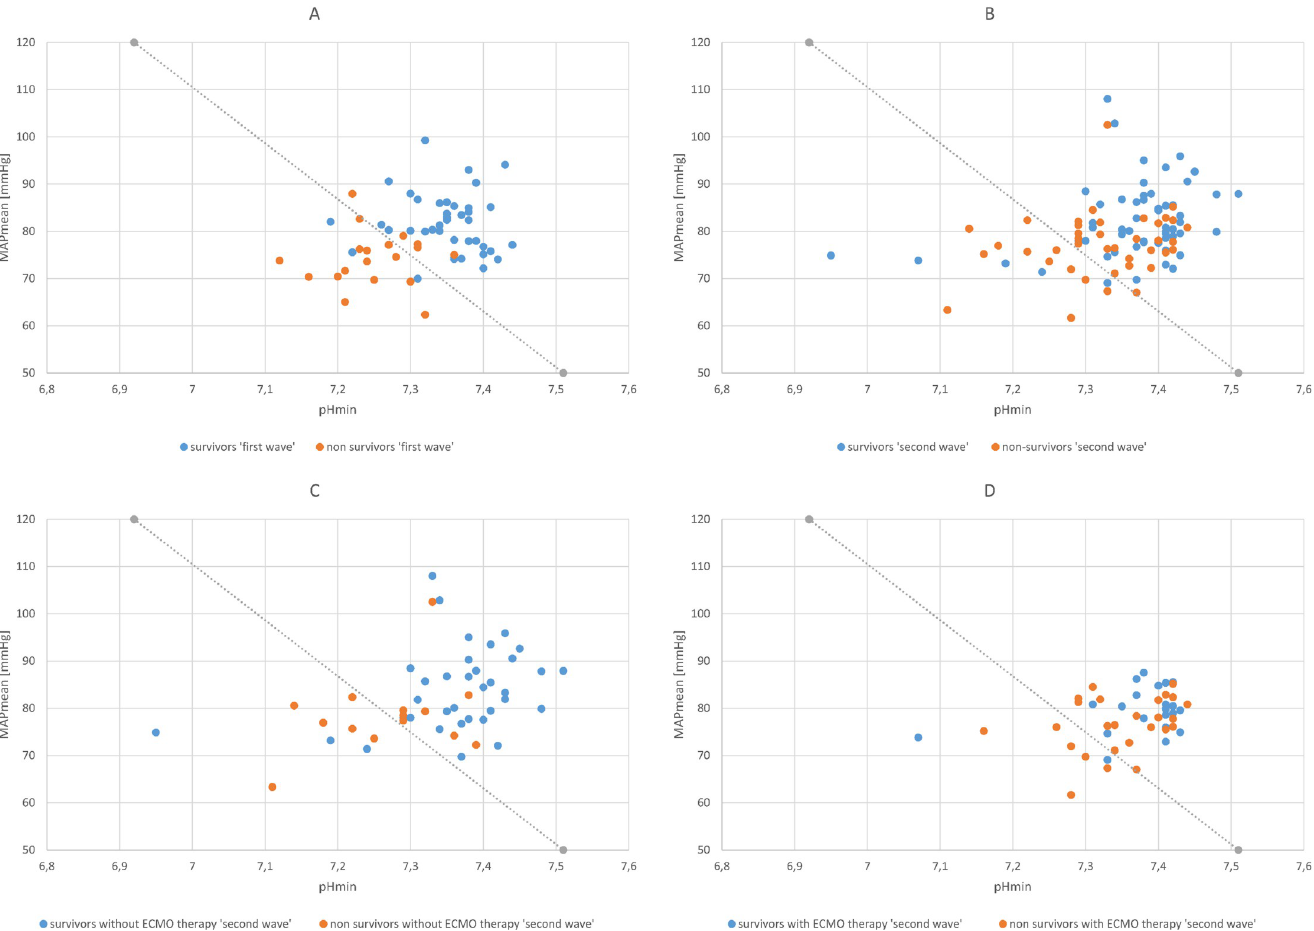
Fig 2. Visualization of the prognostic power of the multivariable regression model and comparison of the first-wave cohort with the second-wave cohort. The cut-off line drawn in the diagrams separates the plane spanned by pHmin and MAPmean into a region below this line with a survival probability < 0.50 and into a region above this line with a survival probability > 0.50. The values calculated for each patient are plotted in the diagram. 2A: All patients of the first-wave cohort. The cut-off line separates survivors and non-survivors with high accuracy. 2B: All patients of the second-wave cohort. The majority of non-survivors appear to be above the cut-off line, which means that many non-survivors would have been falsely prognosed to survive. 2C: Patients with ECMO therapy of the second-wave cohort. In this subgroup, survivors and non-survivors are again separated by the cut-off line with high accuracy. 2D: Patients with ECMO therapy of the second-wave cohort. A useful separation of survivors and non-survivors by the cut-off line is not possible. In the group of non-survivors, there seems to be a shift towards higher values for pHmin. pHmin, minimum pH of blood during the 14-day observation period for each patient; MAPmean, mean MAP during the 14-day observation period for each